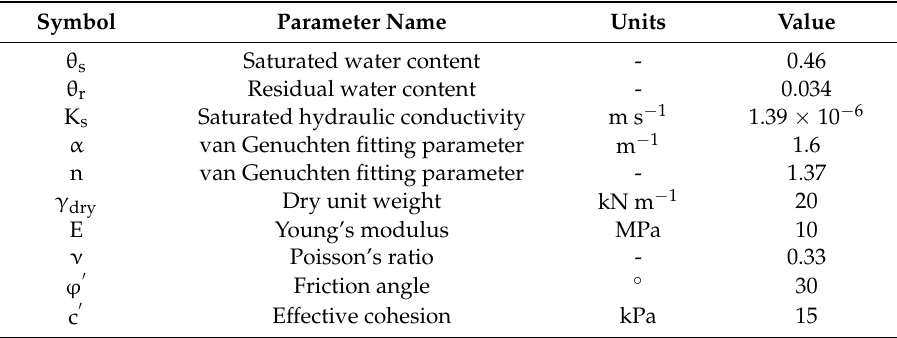
Figure 4. ( a ) The geometry, FEM mesh, and boundary conditions of the 2D benchmark model, and ( b ) the geometry of the 3D benchmark model. The set-up and parameterization of the benchmark model is based on the slope geometry and silty soil used in Lu et al. [30]. Table 1. Soil model parameters for the benchmark models.